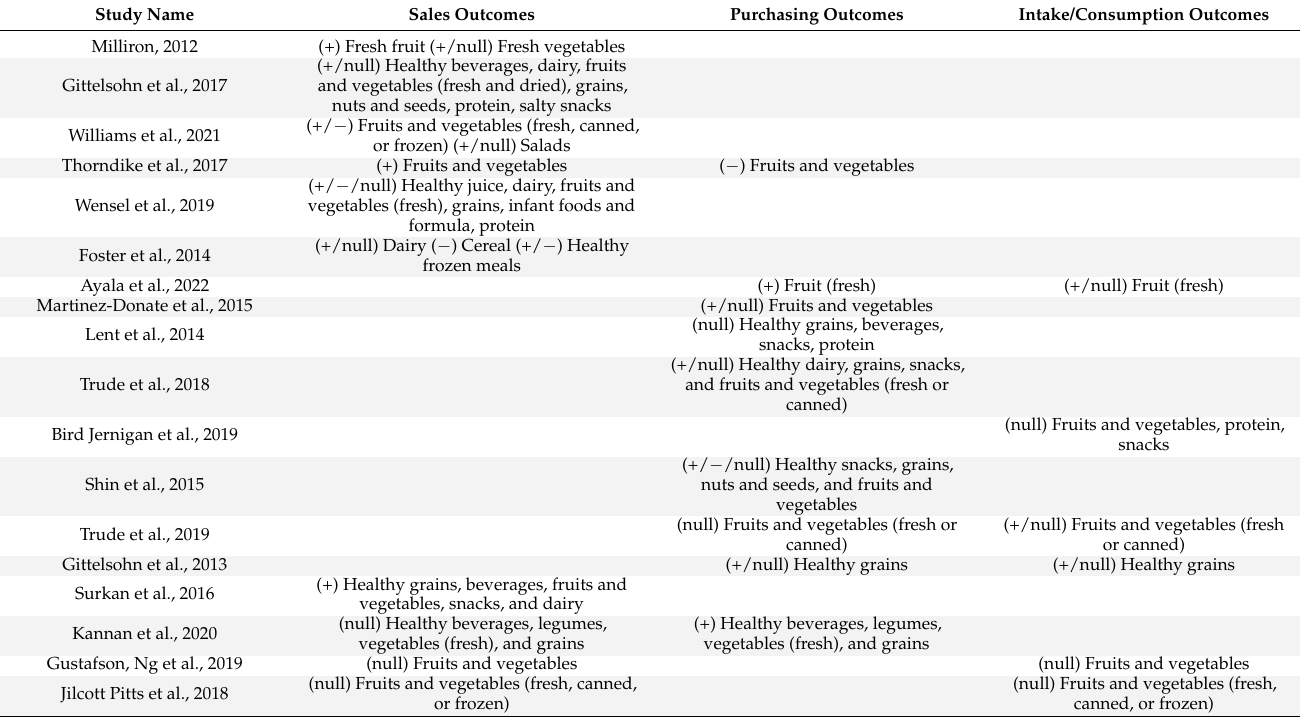
Table A1. Sales, Purchasing, and Intake/Consumption Results of Multi-Component Intervention